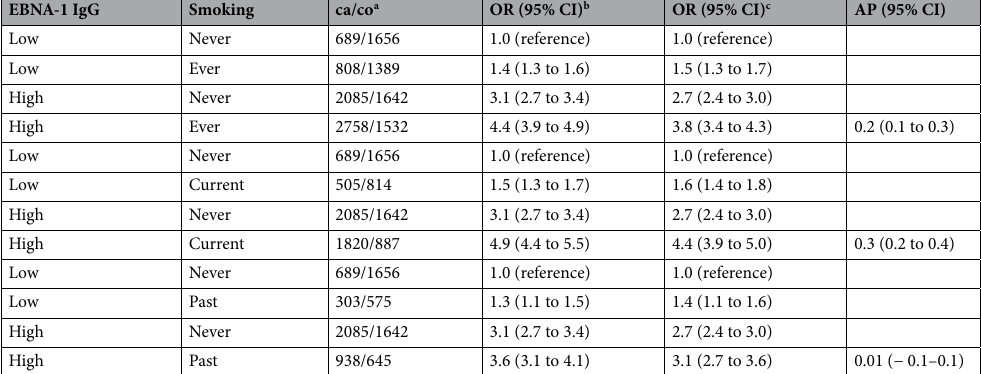
Table 2. OR with 95% CI of developing MS among subjects categorized by EBNA1 status and smoking. AP with 95% CI between high EBNA1 IgG and smoking. a Number of exposed cases and controls b Adjusted for age, sex, residential area, study, and ancestry c Adjusted for age, sex, residential area, study, ancestry,